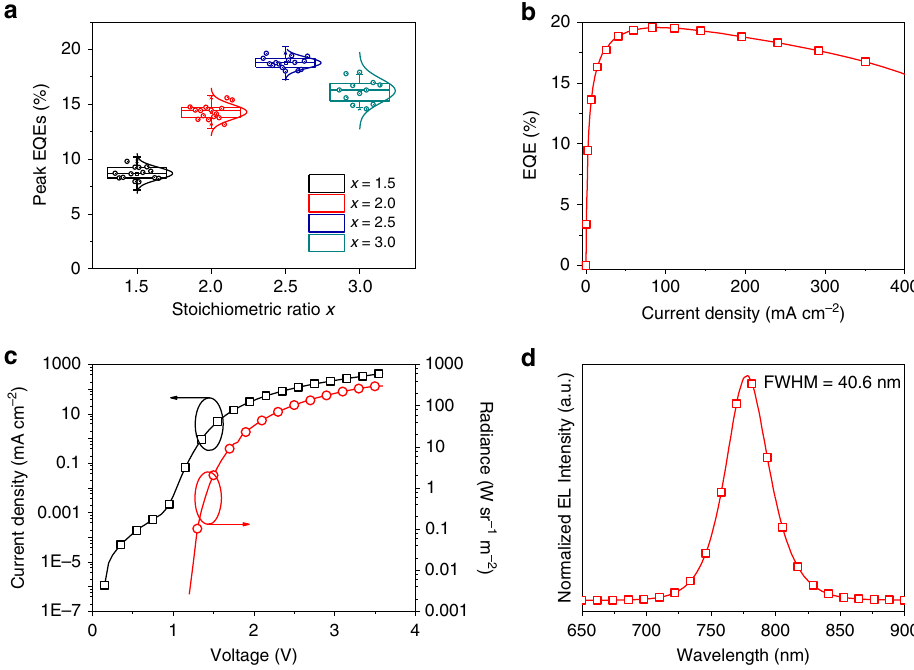
Fig. 5 Device performance of perovskite LEDs with TTDDA passivation. a Statistical distributions of peak EQEs of perovskite LEDs fabricated from TTDDA- containing precursors with different component ratios. b , c EQE -J ( b ), J & R-V ( c ) curves of the champion device with TTDDA passivation. d Normalized EL spectrum of the champion device operated at an applied voltage of 3.5 V. For all box plots, the line in the center is the median value. The interquartile range (IQR) represents 25th-75th percentile of the EQE values. Whiskers show the extent of the whole EQE values, extending to 1.5 IQR in